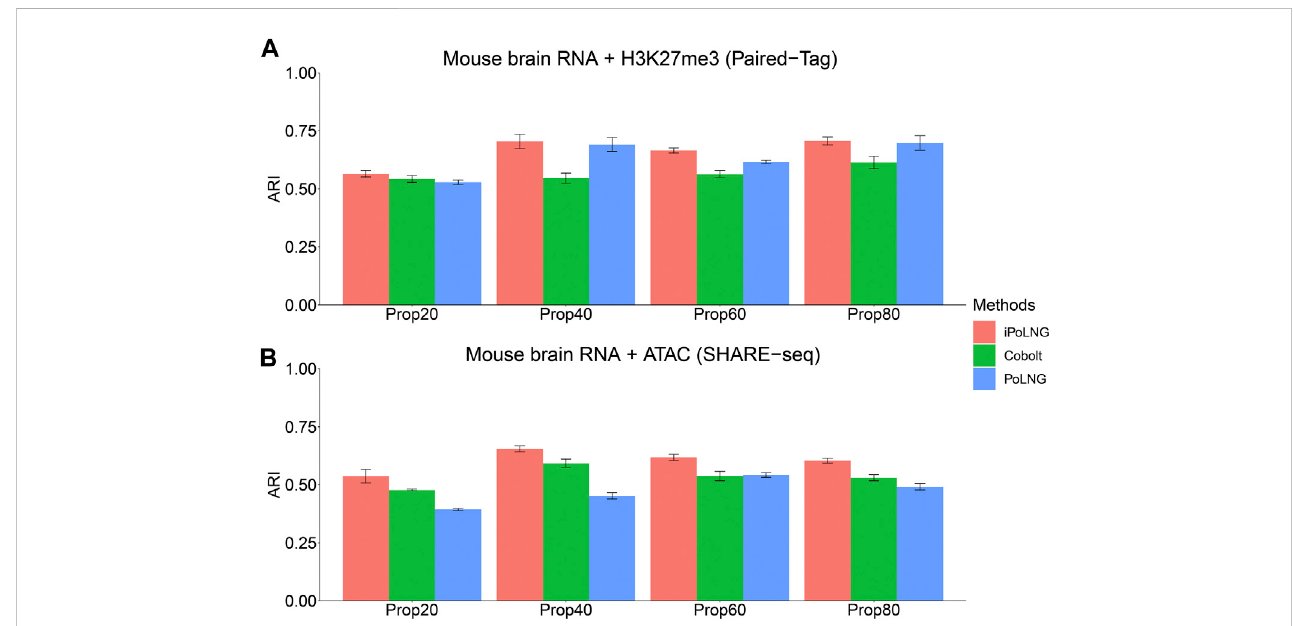
FIGURE 4 ClusteringperformanceofiPoLNG,CoboltandPoLNGonthepartiallymaskeddatasetfor (A) Paired-TagmousebrainRNA+H3K27me3and (B) SHARE- seq mouse brain RNA + ATAC. We set the percentage of masked cells to be 20%, 40%, 60% and 80% of all the